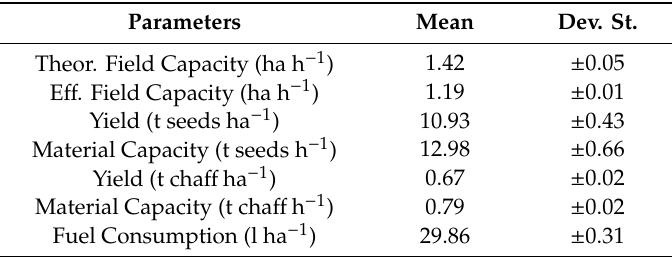
Table 6. Results of the wheat grain and cha ff harvesting test with combine harvester CASE IH 7140 and Harcob system.